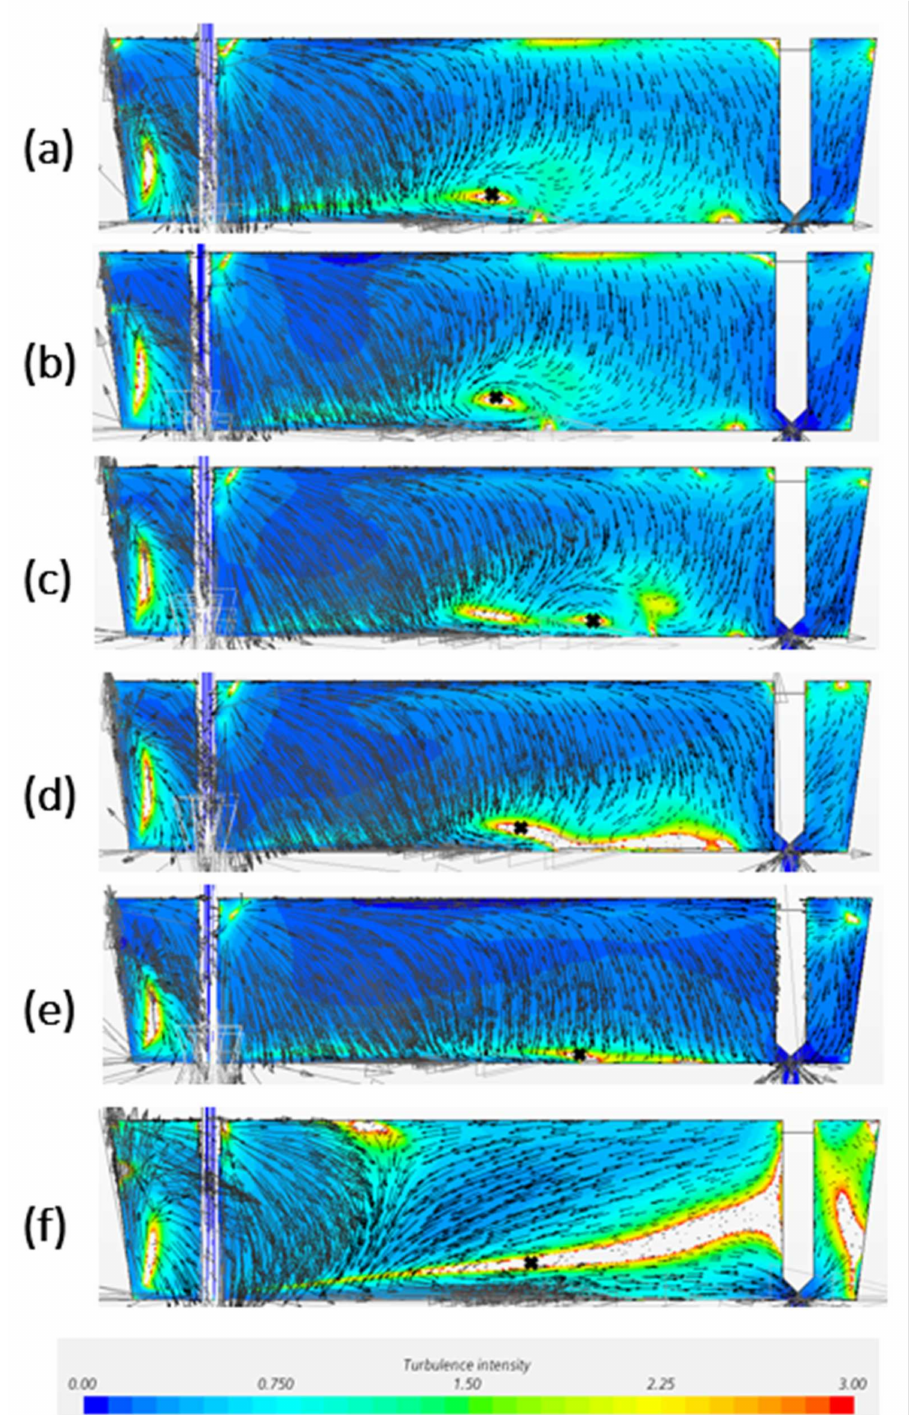
Figure 8. Velocity and turbulence intensity of water model tundish (mesh size: 0.006 m) with turbulence model of ( a ) SKE, ( b ) RKE, ( c ) VKE, ( d ) EBKE, ( e ) SKW, ( f ) RSM on symmetry